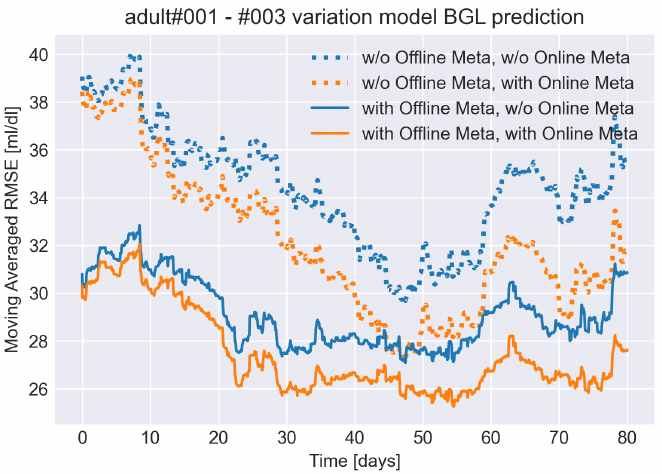
Figure 7. The figure shows the mean squared error (MSE) with a 20-day moving average length. The x-axis shows time steps in days. All of the results use the two-day sliding window. The dotted lines are for the model without offline meta-learning. The solid lines are for the model with offline meta-learning. The blue lines are for the model without online meta-learning. The orange lines are for the model with online meta-learning. The MSE at the beginning shows the offline meta-learning improves MSE. As time progress, the model with online meta-learning results improves over the results without online